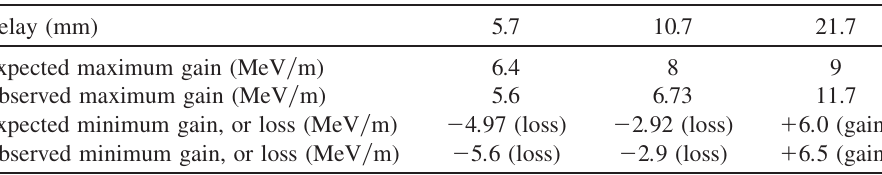
TABLE III. Comparison of observed energy gain/loss values with the model predictions.